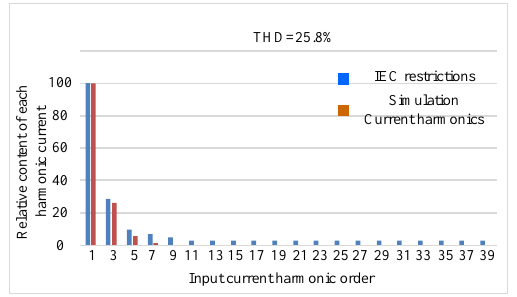
Figure 17. The content of each order harmonic component in the input current through simulation.